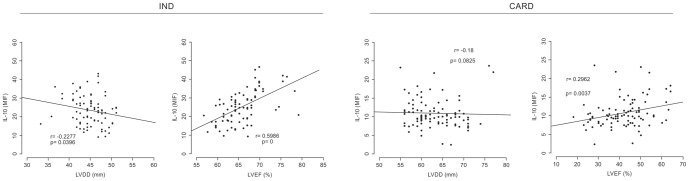
Correlation analysis between plasma IL-10 levels and echocardiographic variable markers of cardiac morbidity.Correlation analysis between plasma IL-10 levels and cardiac function variables (LVEF and LVDD) in the IND (n = 82, first column) and CARD (n = 94, second column) groups. Correlation analysis was performed using the Spearman correlation coefficient, and results were considered significant when P<0.05. Significant differences (P-value) are indicated in each graph together with the r value.